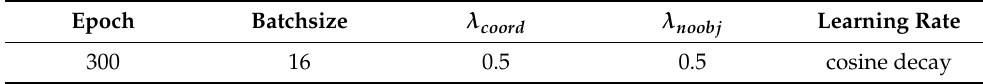
Table 1. The hyperparameter settings in model training.